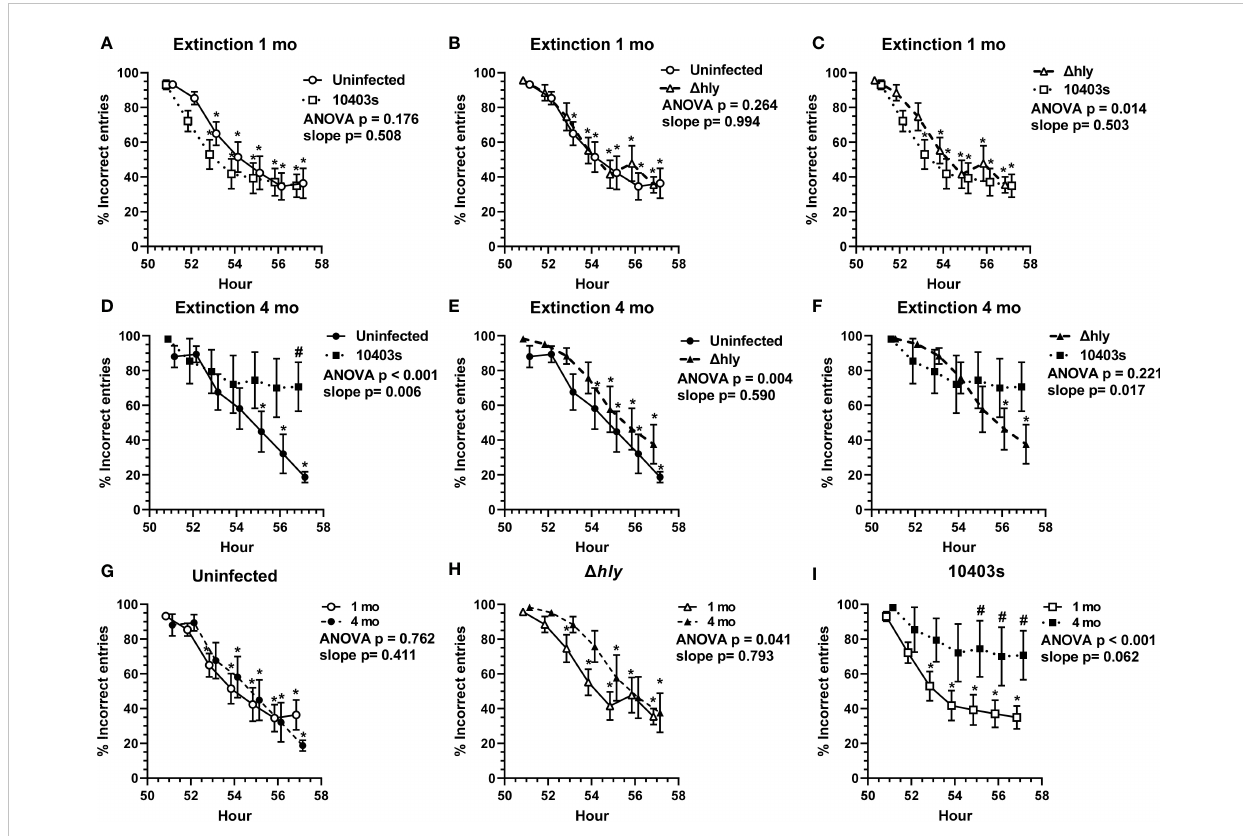
FIGURE 4 Lm infection impairs ability to extinguish prior learning. The % incorrect entries (#left door + #middle door)/total # entries x 100 of mice from hours 51-57 at the beginning of the reversal phase were analyzed to measure the animal ’ s ability to extinguish prior learning. Figures show mean +/- SEM % incorrect entries measured 1 mo (A – C) and 4 mo (D – F) after infection or injection, or according to treatment groups at 1 mo and 4 mo (G – I) from uninfected mice ( ● n=11, ○ n=7), and from mice recovered from infection with Lm D hly ( ▲ n=9, D n=7) or Lm 10403s ( ■ n=11, □ n=5). Symbols at the same time are offset for clarity. p values from 2-way ANOVA comparing extinction curves are given. 2-way ANOVA was used to identify discoveries (q < 0.05) between comparator groups at the same time point are indicated by (#). Discoveries (q < 0.05) in the same test group compared to its own hr 51 are shown by (*). Signi fi cant differences between slopes of regressions lines were determined by Analysis of Covariance (ANCOVA) to calculate a two-tailed P value.